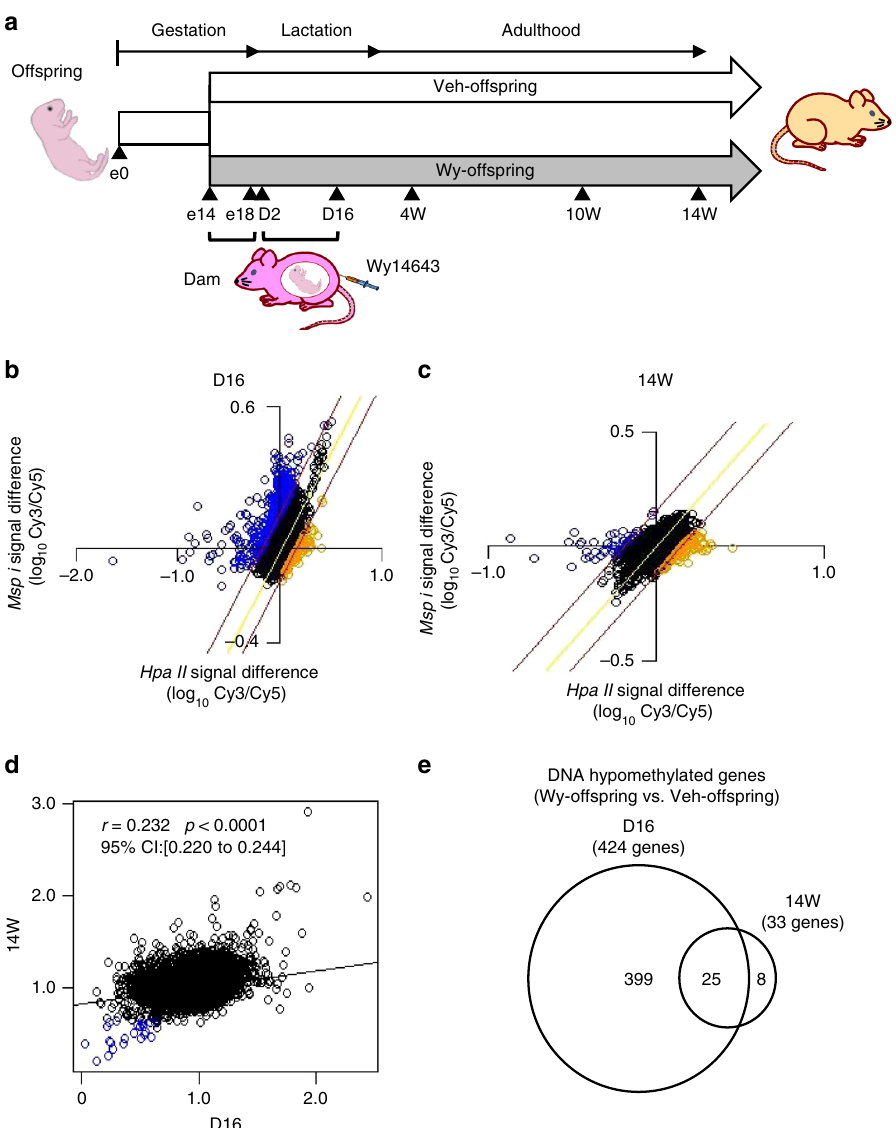
Fig. 1 Genome-wide DNA methylation analysis of Wy-offspring. a Experimental protocol of genome-wide DNA methylation analysis in the liver of offspring derived from dams-administered Wy (Wy-offspring) or DMSO (Veh-offspring) during the late gestation (e14 – e18) and lactation periods (D2 – D16). b , c MIAMI analysis comparing vehicle (labeled with Cy3) with Wy (Cy5) at D16 ( b ) and 14W ( c ). Plots of log transformed values of Hpa II (methylation- sensitive, horizontal axis) and Msp I signal difference (methylation-insensitive, vertical axis) between samples. The values of Hpa II signal difference /Msp I signal difference judged as increased and decreased DNA methylation are above 1.4 and below 0.65, respectively. The regression line is in yellow and red lines are located log 10 1.4 and log 10 0.65 of the horizontal distance from the regression line. Orange and blue circles are judged as hypermethylated and hypomethylated, respectively. d A correlation plot showing the differences at 14W ( y -axis) vs. D16 ( x -axis). Genes, which are hypomethylated both at D16 and 14W are highlighted as blue circles. e Venn-diagram showing the result of MIAMI analysis. Four-hundred and twenty-four genes were DNA hypomethylated in Wy-offspring relative to that in Veh-offspring at D16 and 33 genes at 14W, respectively. Consequently, we identi fi ed 25 genes that were DNA hypomethylated in Wy-offspring relative to that in Veh-offspring both at D16 and